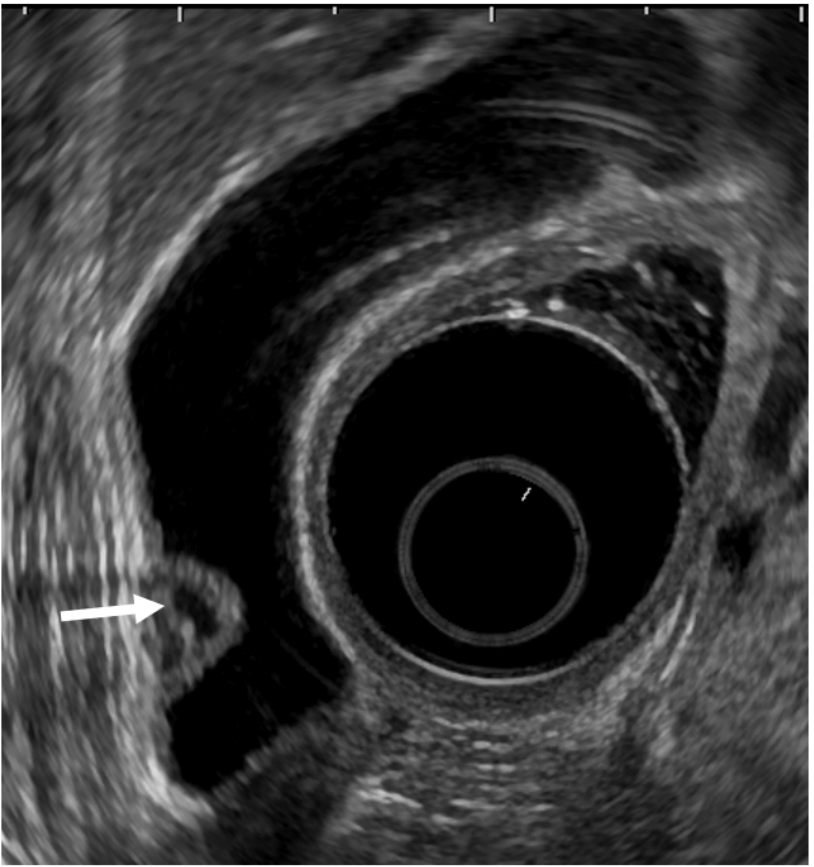
Figure 3. EUS image ADM (localized type). EUS shows localized ADM as a sessile polypoid lesion with anechoic areas (arrow) corresponding to RAS proliferation. The surface is relatively